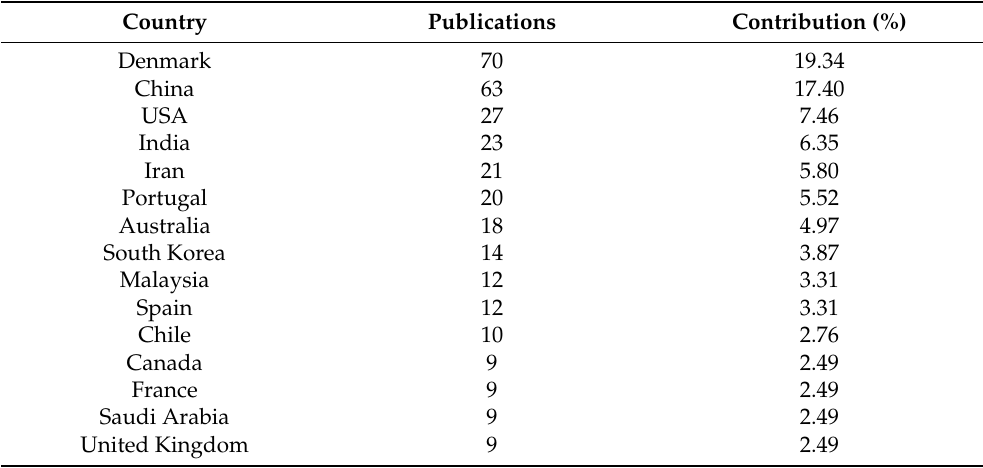
Table 3. The top 15 most productive countries (at least 9 documents).